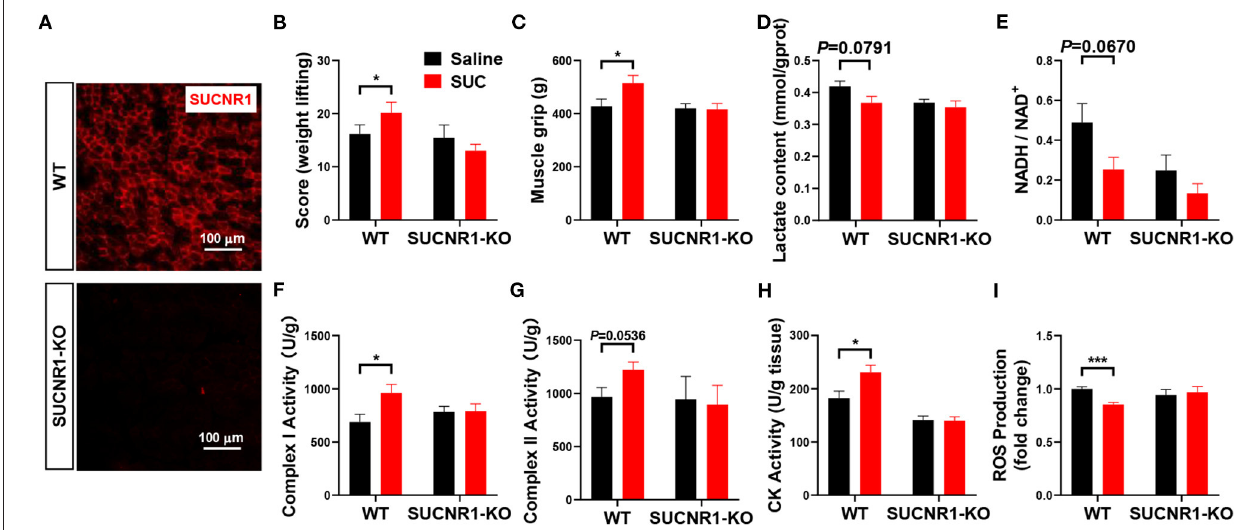
FIGURE 4 | SUCNR1 knockout reversed the effect of SUC on explosive strength. Mice were injected with saline or 15 mg/kg SUC for 1h to detect the muscle force, and then gastrocnemius were collected for the following detection. (A) IF stains red for SUCNR1. (B) Weight lifting and (C) muscle grip to detect the mouse explosive strength. (D) Lactate content. (E) NADH/NAD + ratio change. (F) Complex I activity. (G) Complex II activity. (H) CK activity in muscle. (I) ROS production fold change. Each group n = 6 mice. Each value is shown as the mean ± SEM. *Indicate P < 0.05, ***Indicate P <